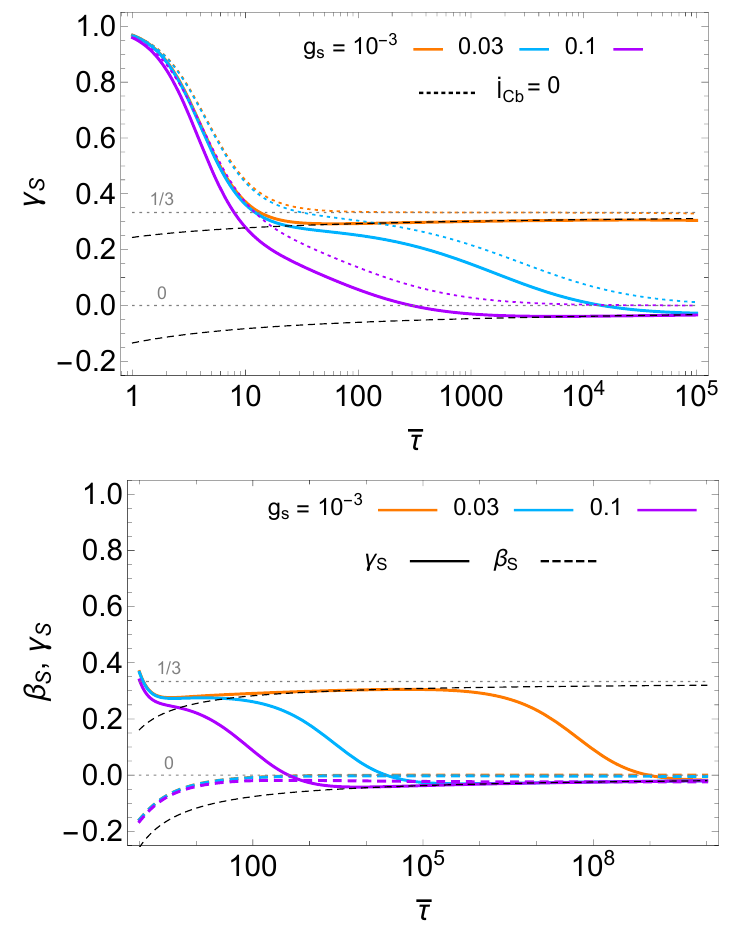
Figure 6 . Evolution of scaling exponents for solutions to eq. (6.6) for γ S with representative values of the coupling constant g s = 10 − 3 (orange), 0 . 03 (blue), and 0 . 1 (purple) are shown in solid lines, for σ 0 = 0 . 1 (top) and σ 0 = 0 . 6 (bottom). The evolution of β S is shown by colored dashed lines in the bottom panel ( β S = 0 in the top panel). In the top panel, colored dotted lines show solutions with ˙ l Cb = 0 for the same set of g s . Thin dashed black lines show results for the fixed points including anomalous dimension corrections from eqs. (6.24) and